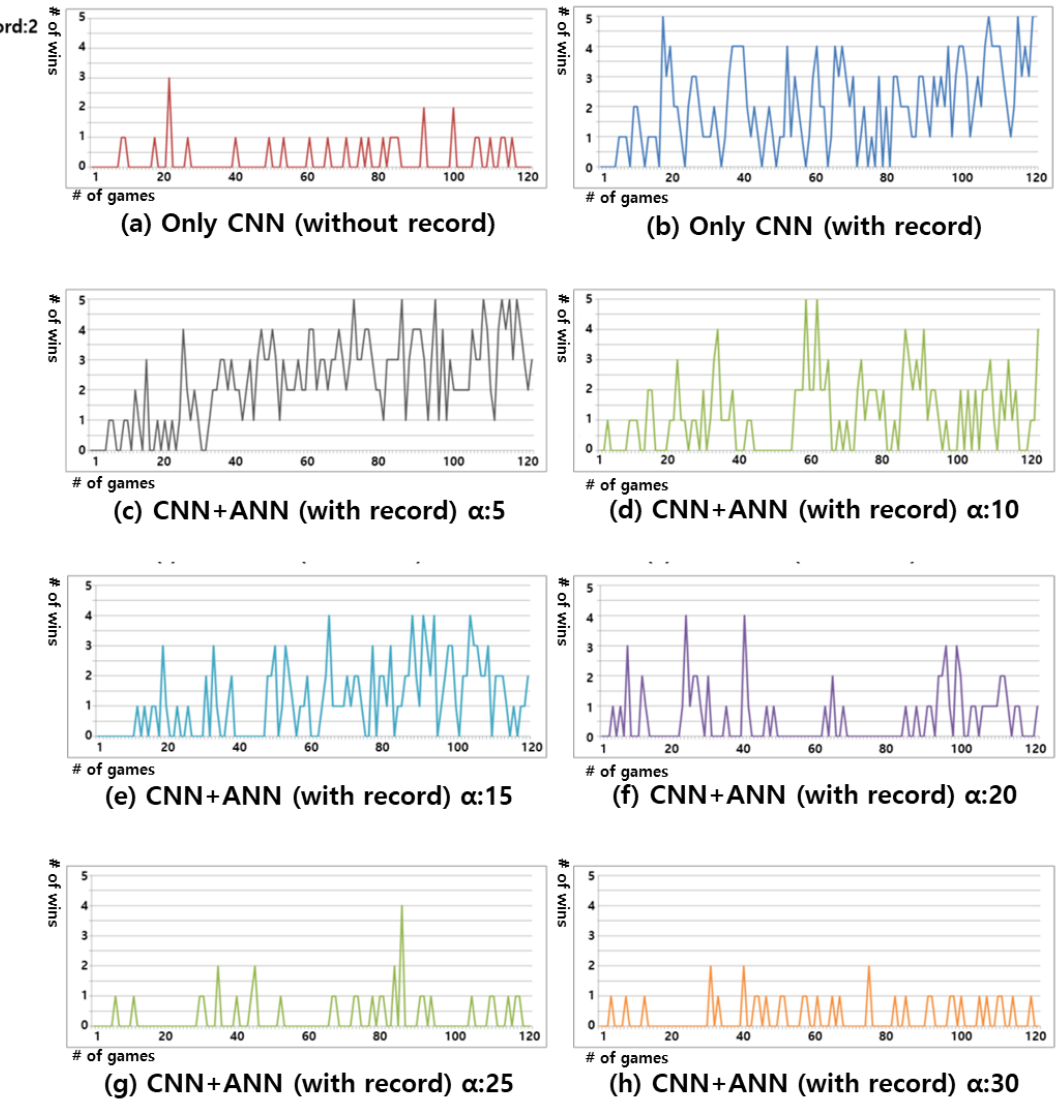
Figure 8. Results of win rate when the record count was two. Each graph y -axis refers to the number of wins from 0 to 5, and the x -axis refers to the number of games from 0 to 120. The figures show the experimental result using: ( a ) only CNN without Record relearning; ( b ) CNN with Record relearning without ANN; ( c ) Proposed Gomoku system with ANN α :5; ( d ) Proposed Gomoku system with ANN α :10; ( e ) Proposed Gomoku system with ANN α :15; ( f ) Proposed Gomoku system with ANN α :20; ( g ) Proposed Gomoku system with ANN α :25; and, ( h ) Proposed Gomoku system with ANN α :30.